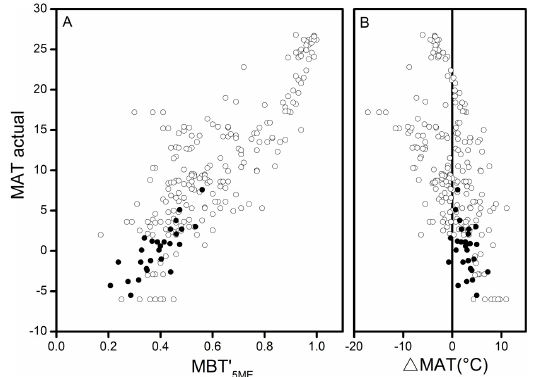
Figure 5. (a) Scatterplot of MBT’ 5ME with actual MAT; (b) differ- ence between estimated MAT and actual MAT ( (cid:49) MAT). Solid and empty circles represented soils in this study and global soils (De Jonge et al., 2014),